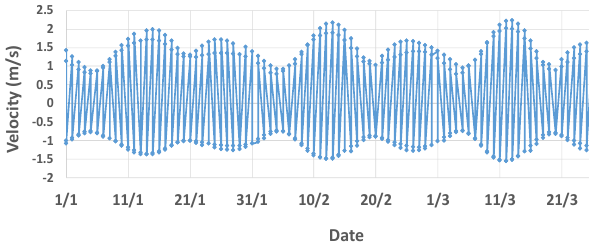
Fig.7. Velocity currents at Nuevo Gulf inlet. January-February- March, 2018 period [22]. The speed calculations were performed following the methodology proposed by [38].